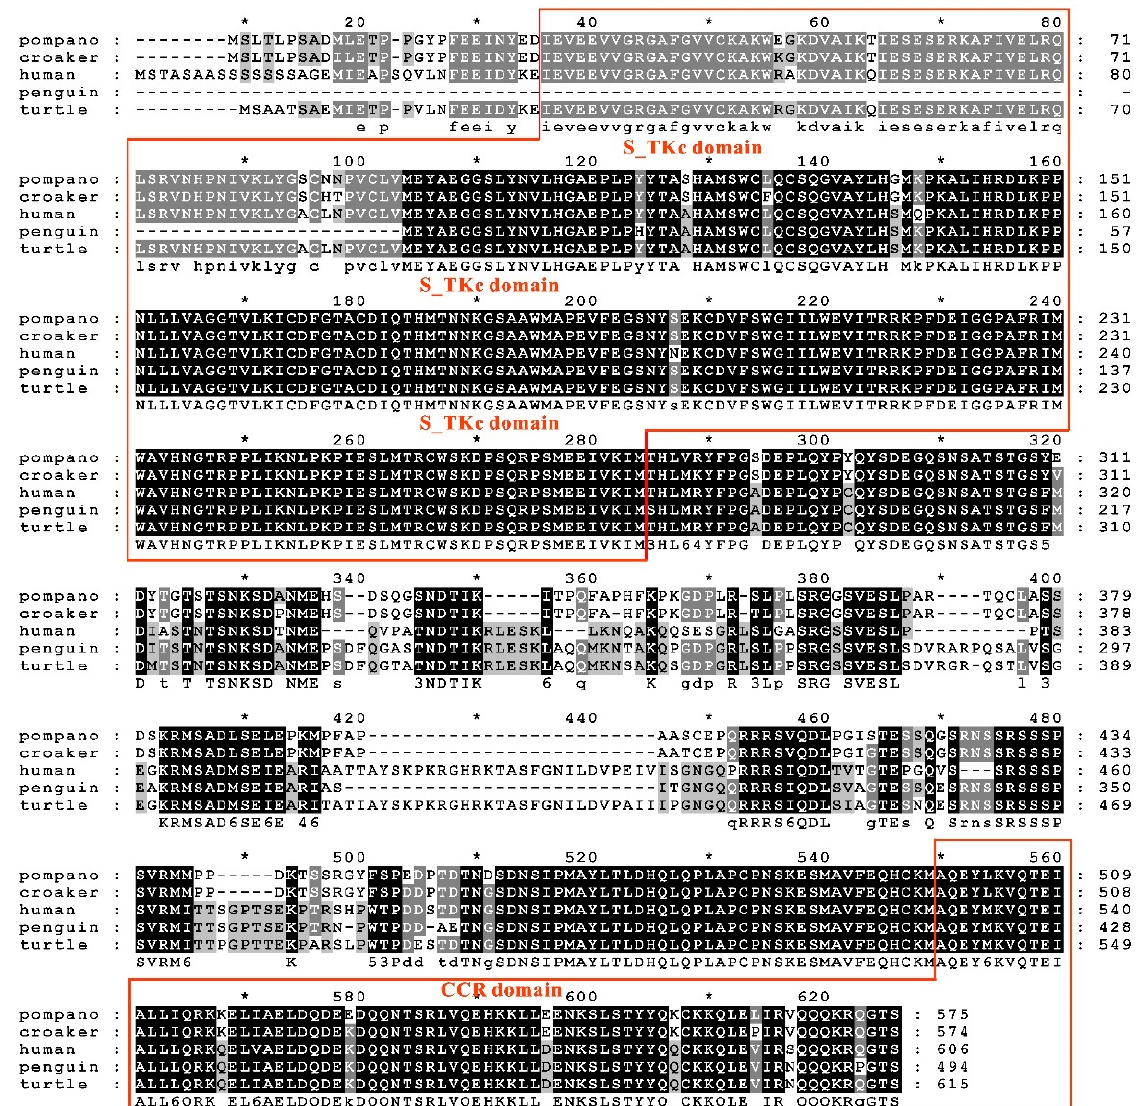
Figure 2. Multiple amino acid sequence alignment between trTAK1 and other vertebrates’ TAK1. The S_TKc and CCR domains of trTAK1 are boxed. Asterisk is regarded as the number of amino acids, and there will be one asterisk for every 10 amino acids. The species are golden pompano ( T. ovatus ), large yellow croaker ( L. croea ), human ( H. sapiens ), emperor penguin ( A. forsteri ) and western painted turtle ( C. picta ), and their GenBank accession numbers are listed in phylogenetic tree.